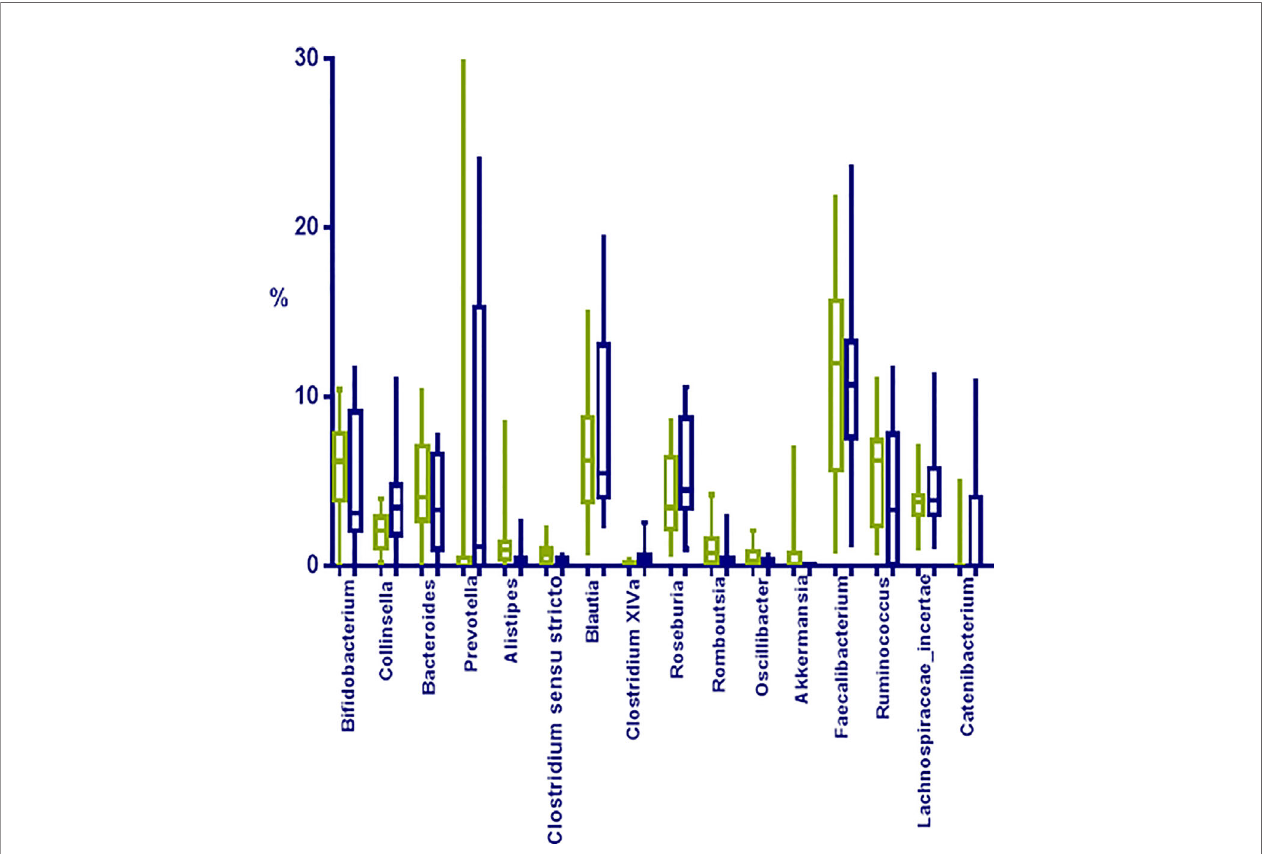
FIGURE 4 | Most represented groups at genera level in fecal samples from normoweight (N, ) and obese (O, ) individuals. The median, minimum, and maximum values are